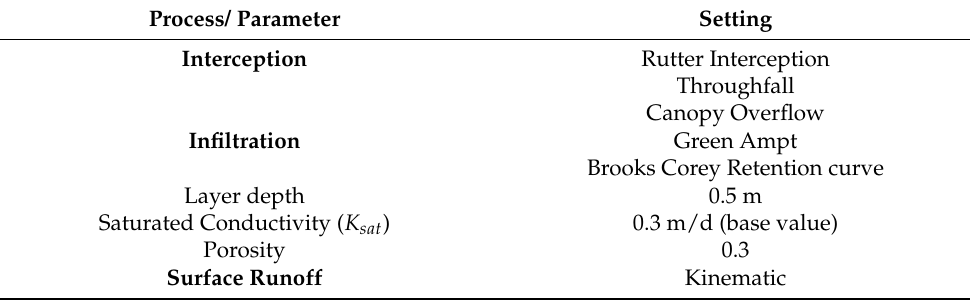
Table 2. Setting and processes in cmf.